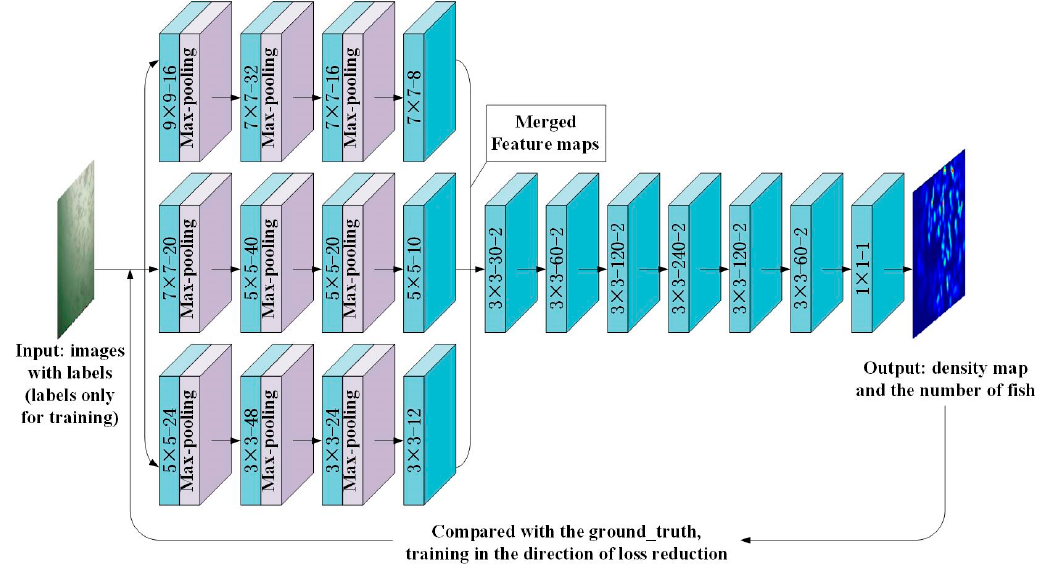
Figure 8. The structure of the proposed model. The convolutional layer’ parameters are denoted as “(kernel size)-(number of filters)-(dilation rate)”; max-pooling layers are conducted over a 2 × 2 pixel window with stride 2.